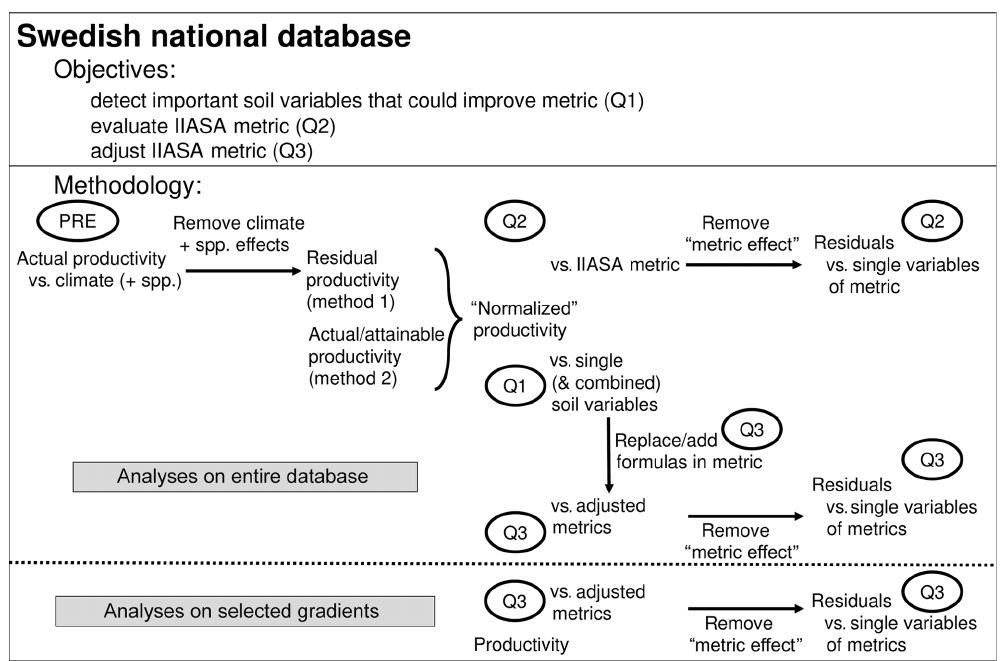
Figure 2. Objectives and methods followed in the current paper. PRE refers to a regression model of productivity vs. climate and species (spp.); Question 1, Question 2, and Question 3 refer to the research questions. Performance of the adjusted nutrient metrics was evaluated against the entire database, and against five nutrient availability gradients, selected from the database (Fig.